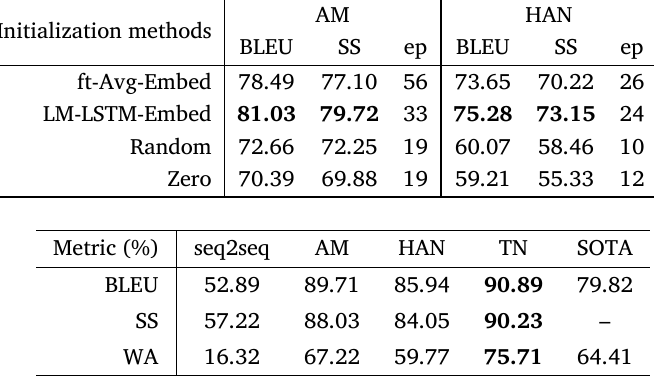
Effect of pre-trained character embeddings for Hindi-Bangla cognate pairs